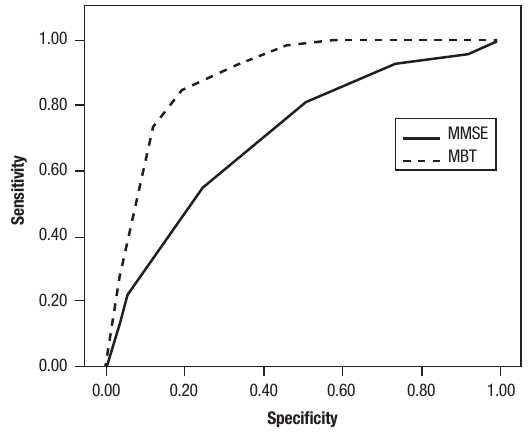
Figure 1. Comparison ROC Curve – MBT (N° Paired recall) vs